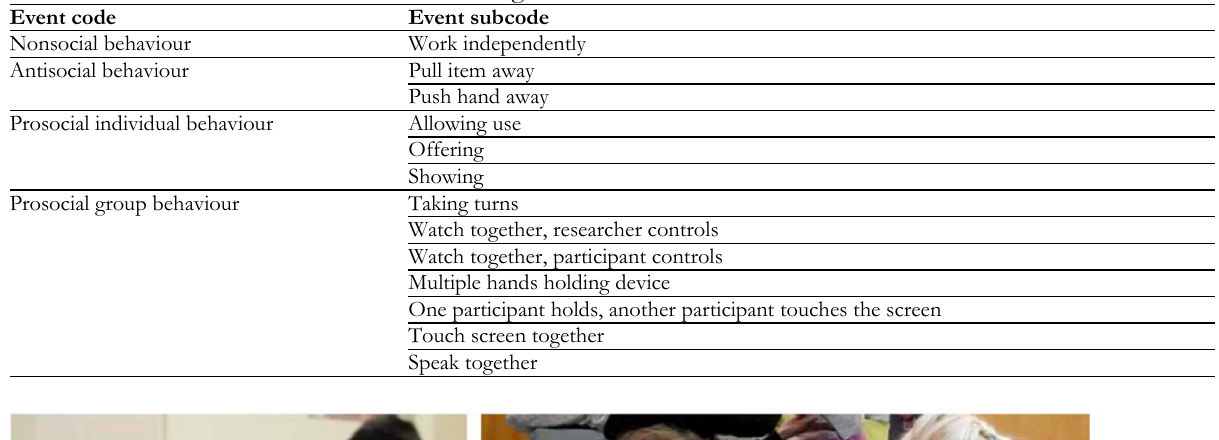
Table 2. Codes and subcodes for children using iPads